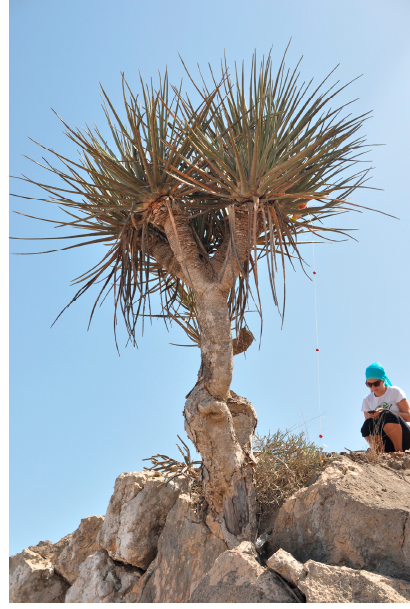
Figure 3. Prism points with a predefined distance in perpendicular vertical to the Earth’s surface. Beads with a mutual distance of 50 cm suspended on a rope ending with the lead are used to define dimensions in the resulting 3D tree point cloud.